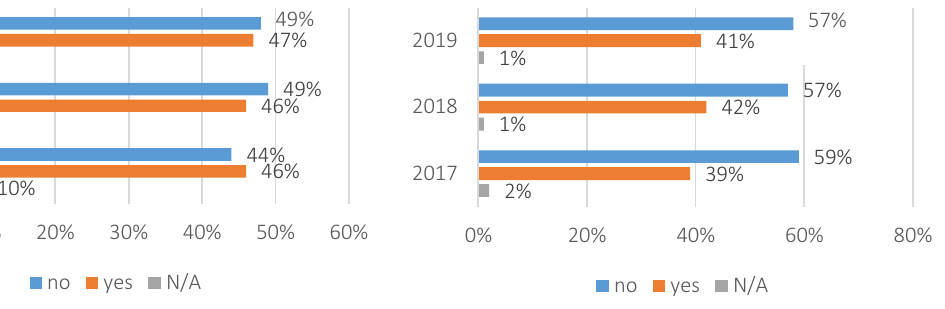
Figure 2. Results of the poll of visitors to the Book Forum in